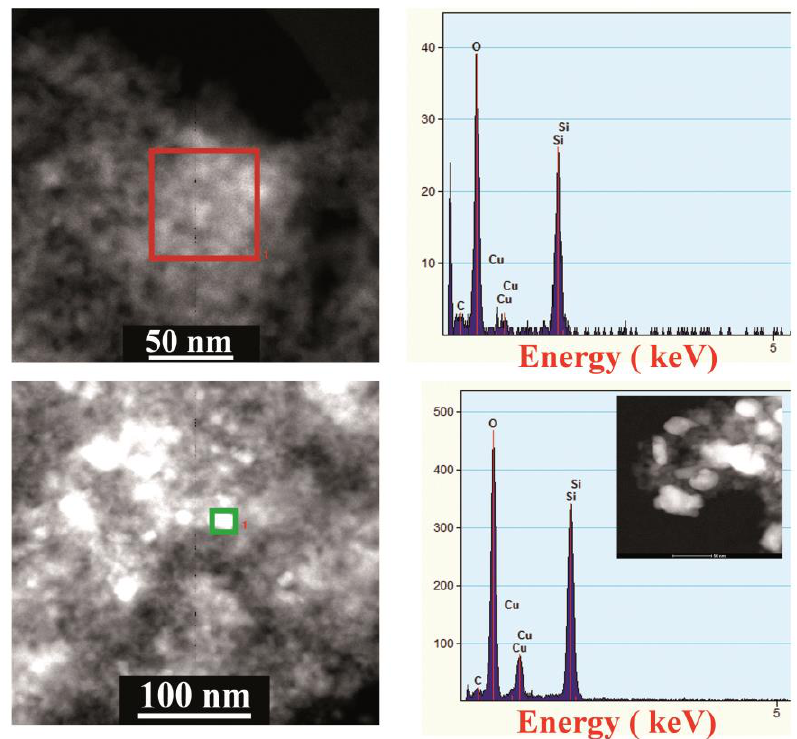
Figure 8. HAADF STEM images of the CuAsc / SiO 2 catalyst after reaction and representative EDX spectrum of a selected area.